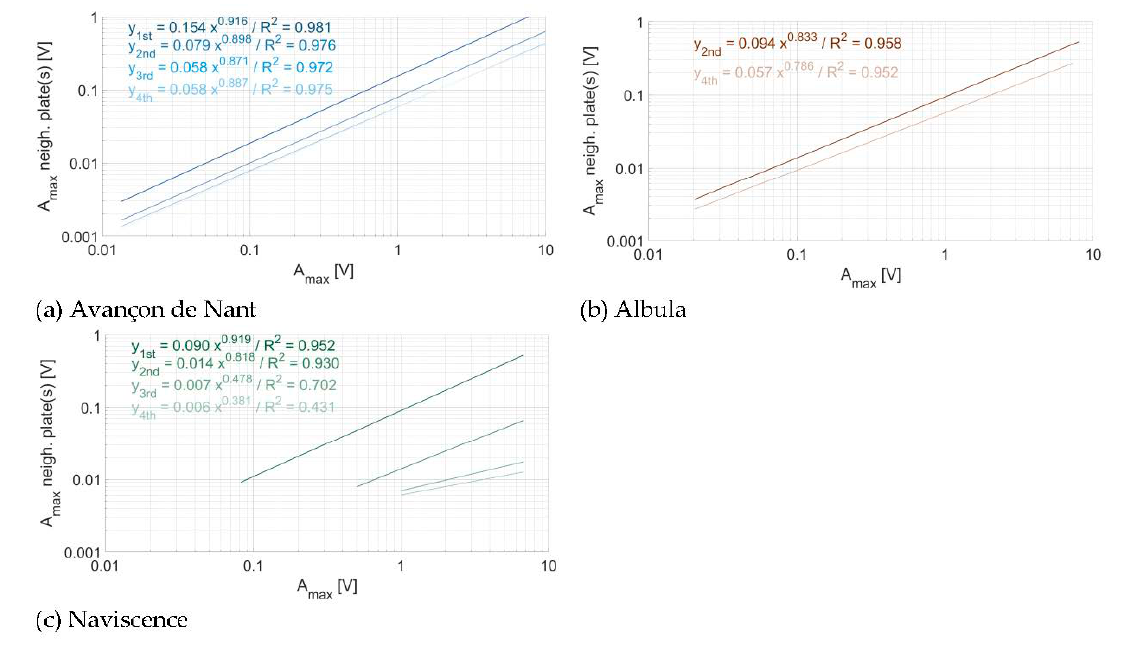
Figure 11. Attenuation of the propagated energy across plates at ( a ) the Avançon de Nant, ( b ) the Albula, and ( c ) the Naviscence measuring stations. Regressions are calculated from all impacts on every plate taken together at each given site.